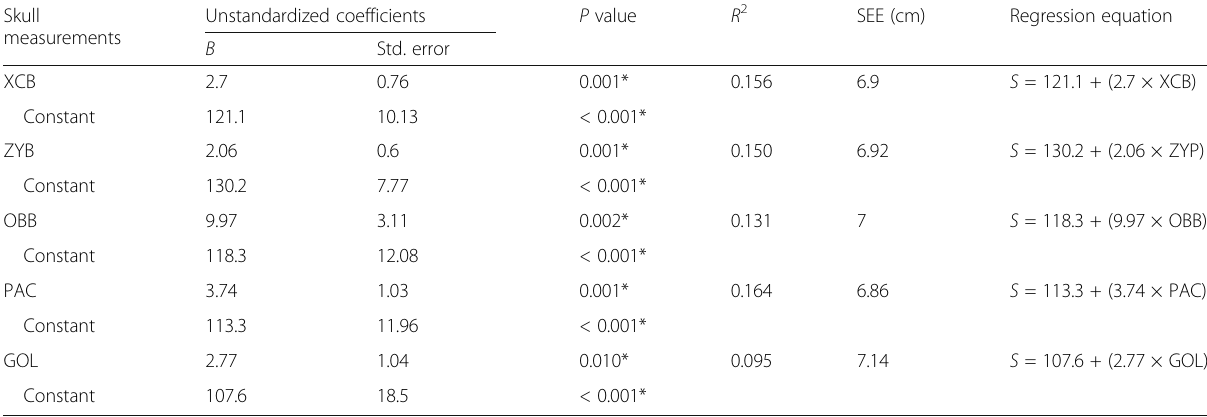
Table 7 Simple linear regression analysis to predict stature from skull measurements in females ( n = 70) Skull